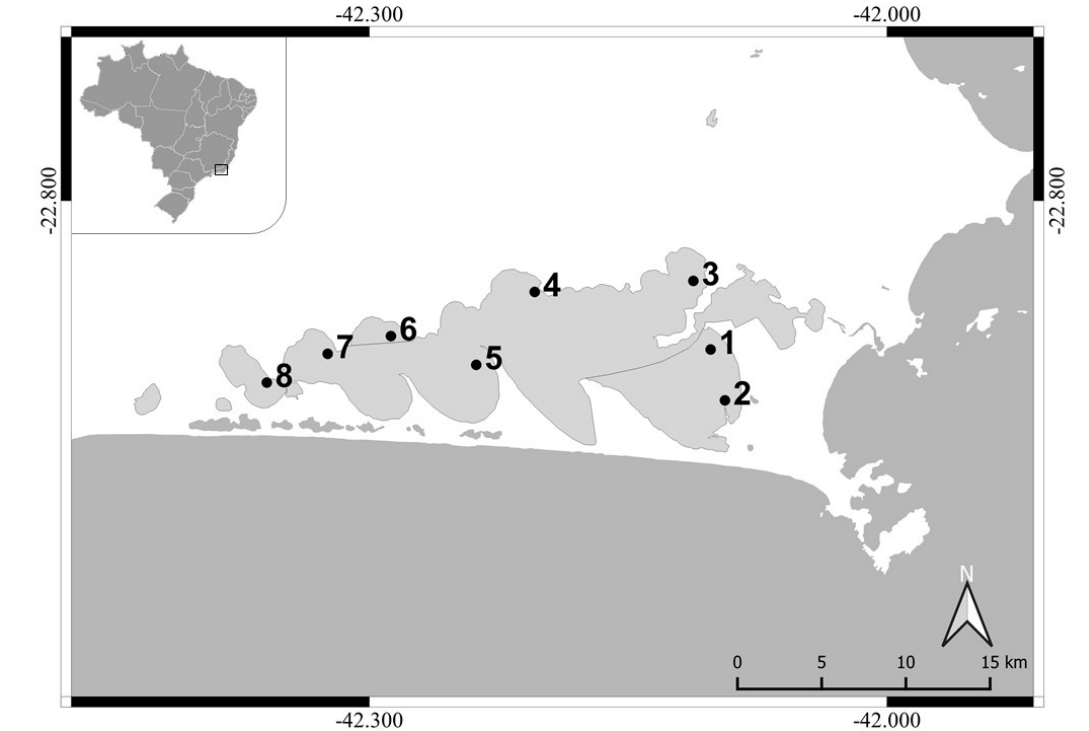
Figure 1. Map of the coast of the state of Rio de Janeiro pointing out the 8 sampling stations of the Araruama